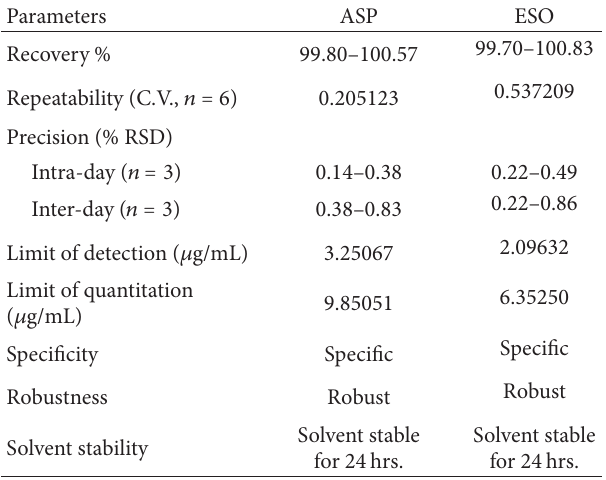
F 4: Overlain spectrum of 10 T 1: Summary of validation parameters.